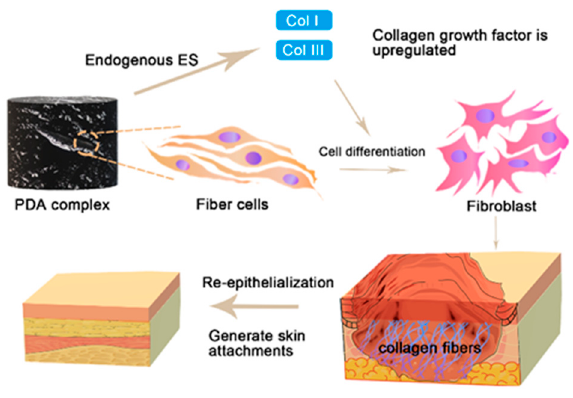
Figure 6. Re-epithelialization of the skin.